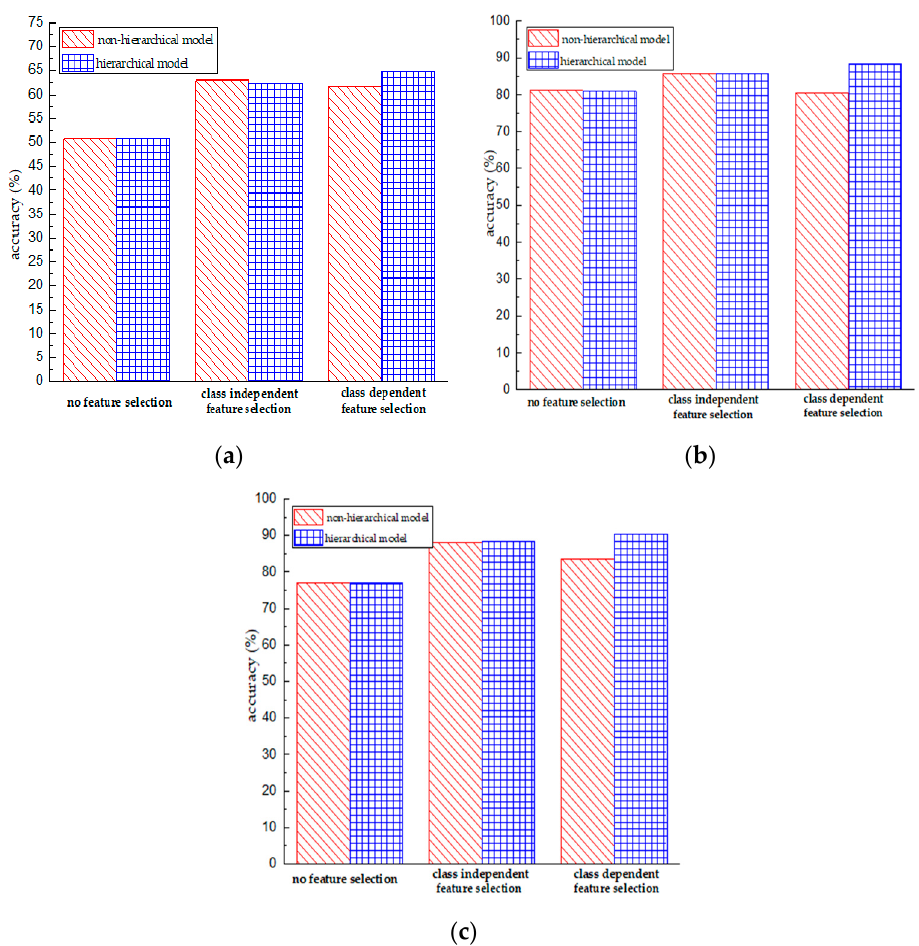
Figure 9. Performance comparison of using the non-hierarchical model and the hierarchical model in the case of no feature selection, class independent feature selection, and class dependent feature selection. ( a ) Performance obtained using the gyroscope data; ( b ) Performance obtained using the accelerometer data; ( c ) Performance obtained using the accelerometer & gyroscope data.